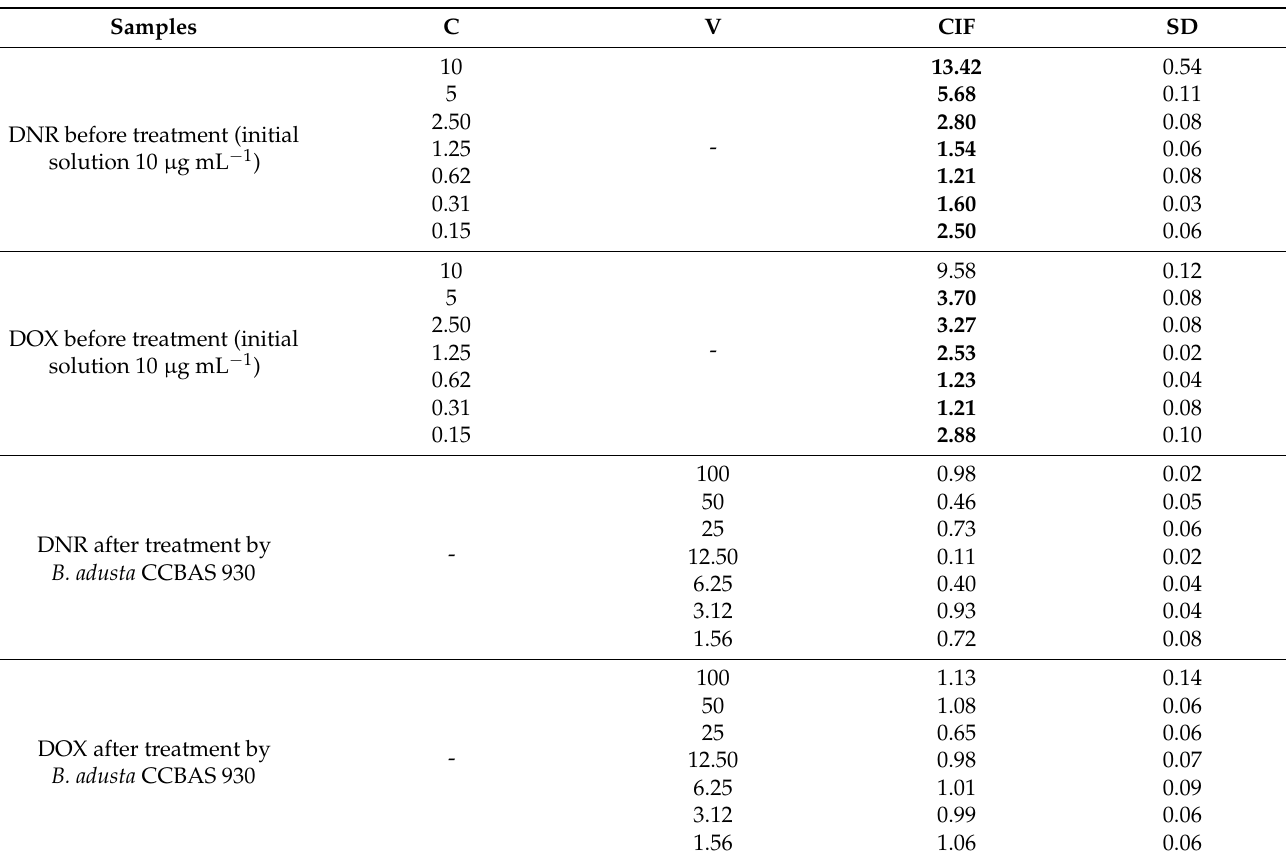
Table A1. Genotoxicity levels of DNR and DOX samples before and after treatment by B. adusta CCBAS in 20-days stationary